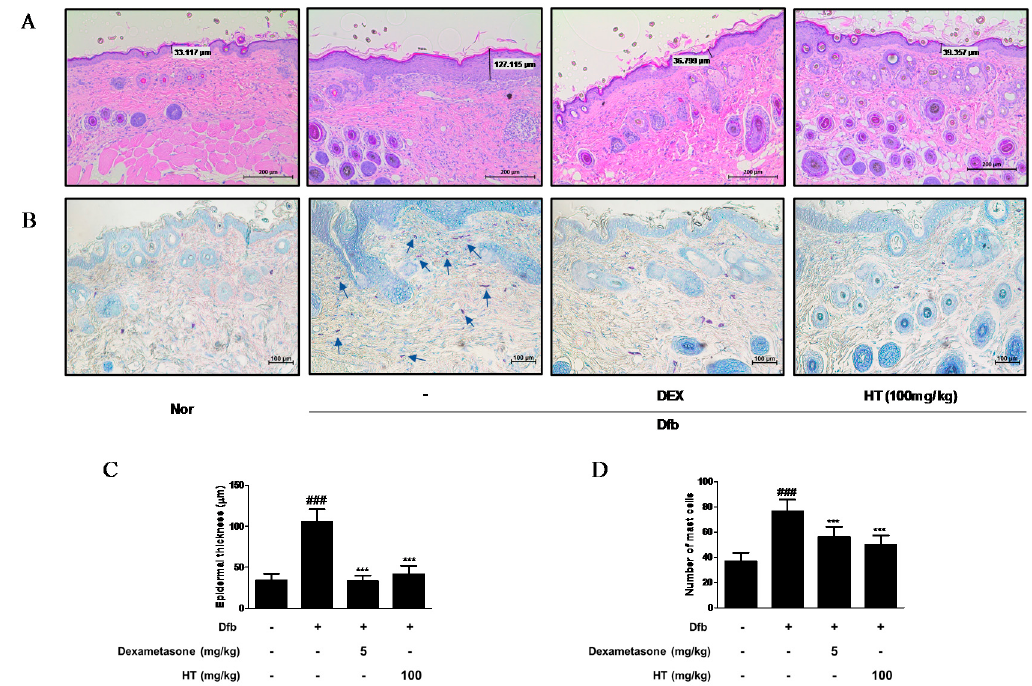
Figure 3. Effects of HT on the histological alterations in Dfb-induced NC/Nga mice. Histological features of the dorsal of NC/Nga mice. Tissues were excised, fixed in 10% formaldehyde, embedded in paraffin, and sectioned. Dexamethasone (5 mg/kg, DEX) was used as a positive control. ( A ) The sections were stained with H&E (scale bar = 200 µ m). ( B ) The sections were stained with toluidine blue to identify mast cells. Blue arrows indicated stained mast cells (scale bar = 100 µ m). ( C ) Epidermal thickness in H&E stained sections were measured under a microscope. ( D ) Mast cells were counted in toluidine stained sections with a microscope. The data shown represent mean ± S.D. of three independent experiments. ### p < 0.001 vs. the control group; *** p < 0.001 vs. Dfb-treated group. Nor: normal; H&E: hematoxylin and eosin.